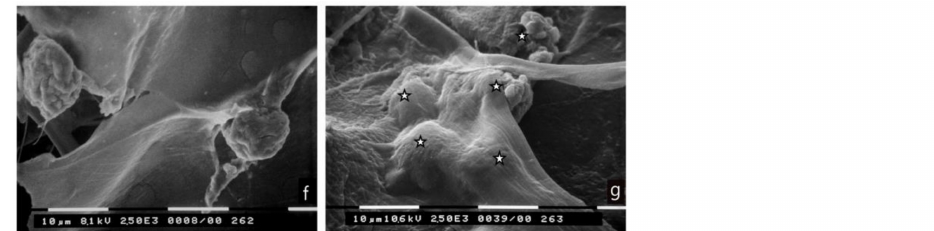
Figure 7. Breast cancer cells cultured on type I collagen fibers bundled orthogonal to the culture plane (TACS III). ( a ) Section of the collagen membrane with collagen fibers orthogonal to the culture plane used as substrate for cultures of breast cancer cells. Inter fiber spaces and channels are available for breast cancer invasion. ( b ) MCF-7 cells lying on the collagen membrane surface mainly show a globular/spherical shape with cytoplasmic convolutions and no microvilli (in the center and on the right), but also some spindle-like cells (arrow). Bar 10 µ m. ( c ) MDA-MB-231 cells on the collagen membrane show a globular/spherical shape with microvesicles on the cell surface. Bar 10 µ m. ( d ) Two globular MCF-7 cells and a flattened/elongated cell showing invadopodia penetrating the collagen membrane surface (arrow) are visible. Cytoplasmic convolutions with no microvilli are detectable on the cell surfaces. Bar 10 µ m. ( e ) MDA-MB-231 cells on the collagen membrane show a globular/spherical shape with few microvesicles. Bar 10 µ m. ( f ) Globular/spherical MCF-7 cells penetrated the thickness of the collagen membrane through inter fibers wide channels. Bar 10 µ m. ( g ) Globular/spherical cells with few microvesicles (stars) partially or completely invaginated a superficial sheet of the collagen membrane. Bar 10 µ m.